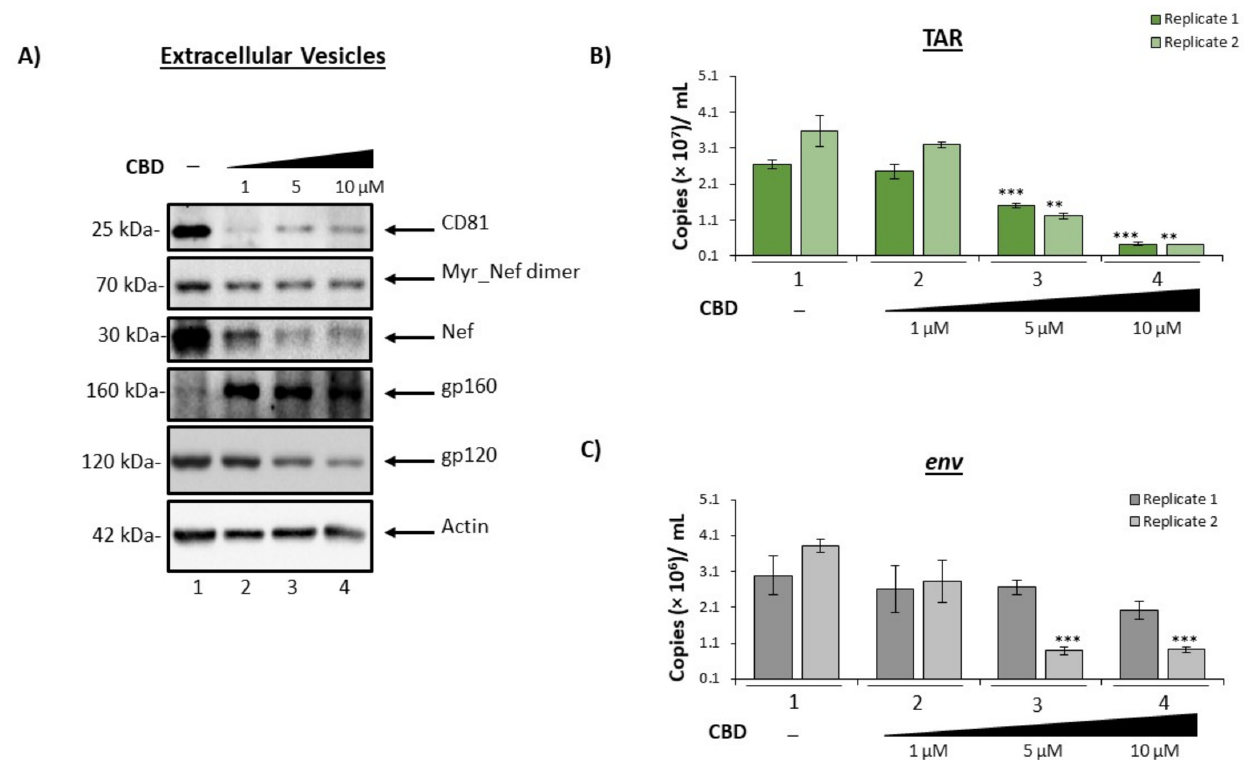
Figure 2. CBD decrease the amount of viral cargo carried inside EVs released from infected monocytes. U1 cells (1 × 10 6 ) were treated with a titration of CBD (1, 5, 10 µ M) every day for 5 days. Cellular supernatant was collected, exosomes were enriched with nanoparticles (NT80/82) beads overnight at 4 ◦ C, ( A ) pelleted, run through SDS-PAGE, and Western blotted for exosomal (CD81) and HIV viral markers (myr-Nef, Nef, gp120), as well as actin. ( B ) Following the same experimental design as ( A ), cellular supernatant was nanotrapped and pelleted. RNA was isolated from the samples, followed by RT-qPCR analysis for HIV-1 viral transcripts, TAR and ( C ) env. Student’s t -test was used for statistical analysis, where ** = p < 0.01, and *** = p <